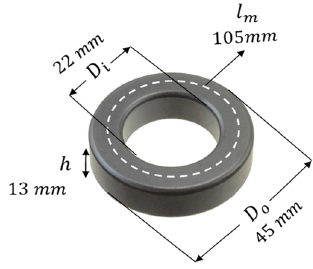
Figure 7. Required measurements for the application of the ASTM A772/A772M standard.